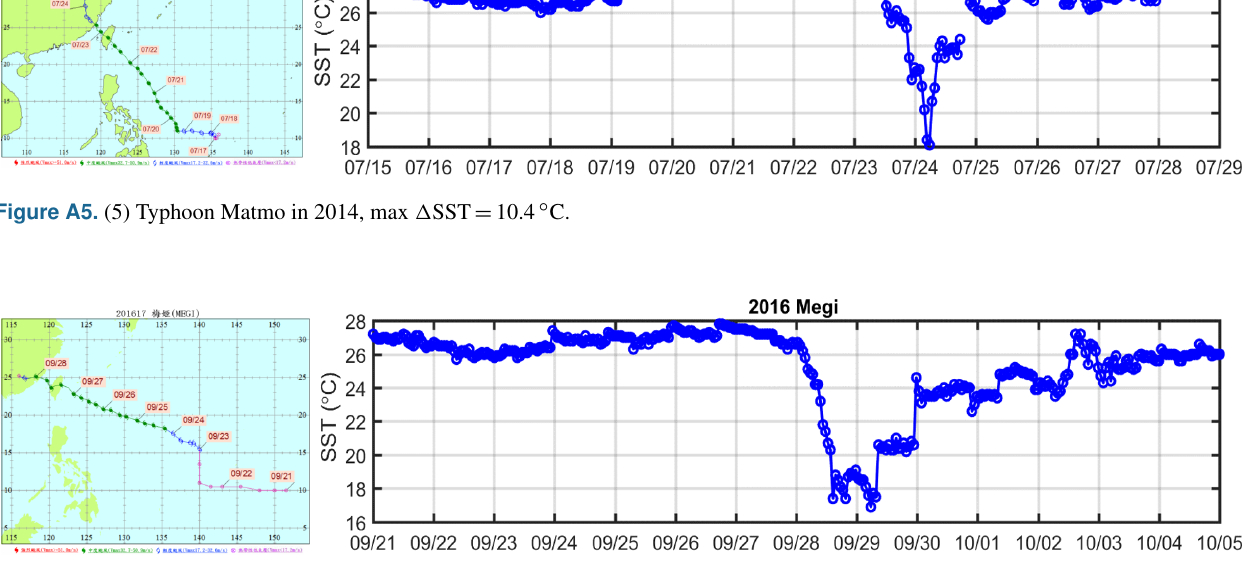
Figure A6. (6) Typhoon Megi in 2016, max (cid:49) SST = 10.0 ◦